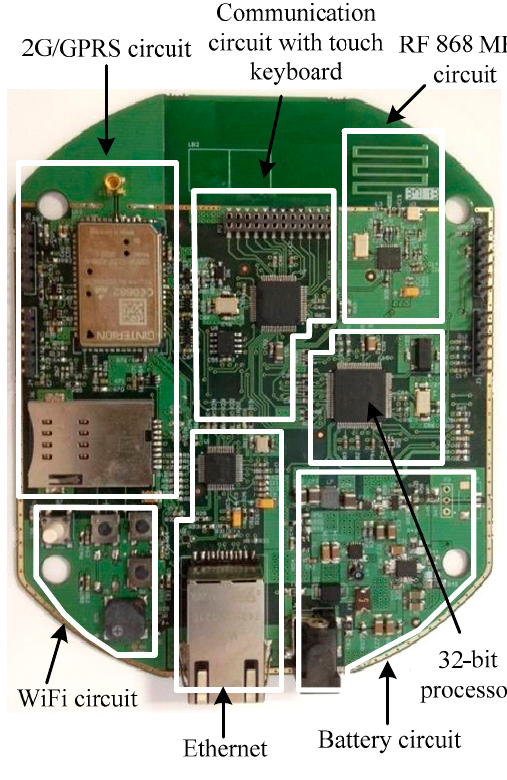
Figure 3. Image of the main board of the base station.